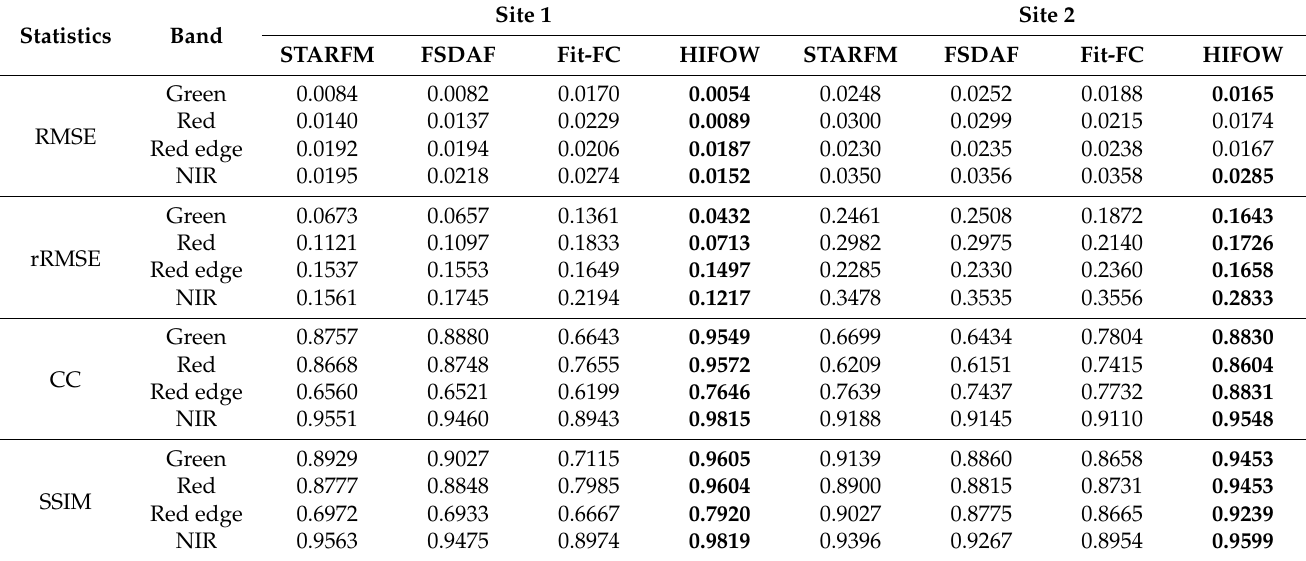
Table 3. Band-wise accuracy statistics of different STIF models at the two study sites. The best case is shown in bold.